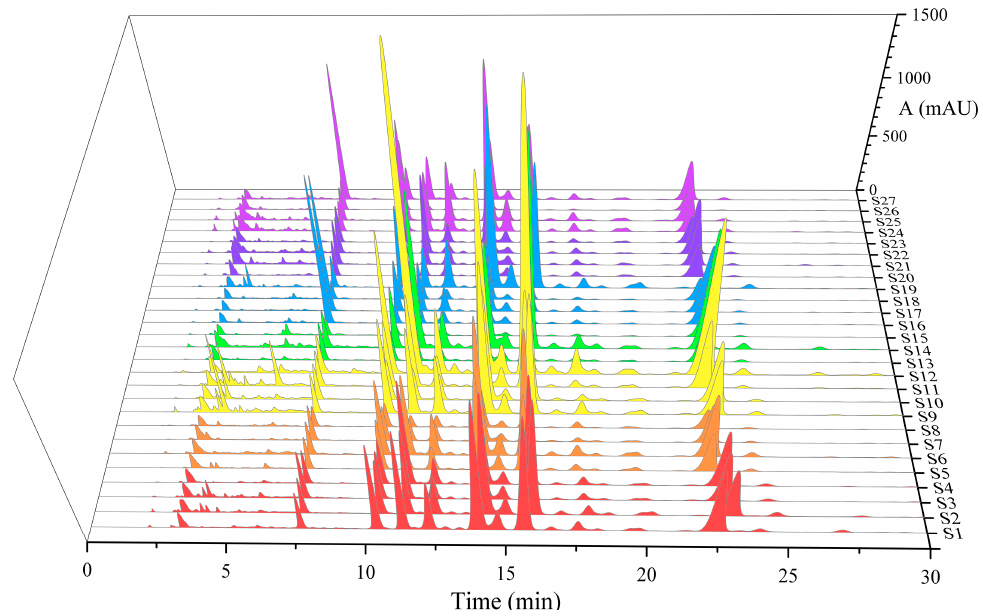
Figure 4. High performance liquid chromatography (HPLC) chromatogram of 27 batches of Oviductus Ranae.